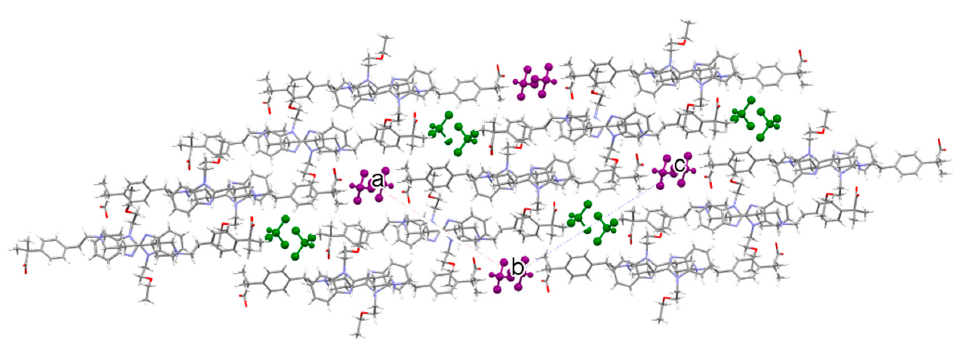
Figure 25. Intermolecular interactions (distances in Å ) observed in solvate S CHCl3 . There are two different chloroform molecules in this solvate: 1-CHCl 3 which is in- volved in a Cl 3 C-H···O=C (distance: 2.008 Å) hydrogen bond with the carboxylate of one